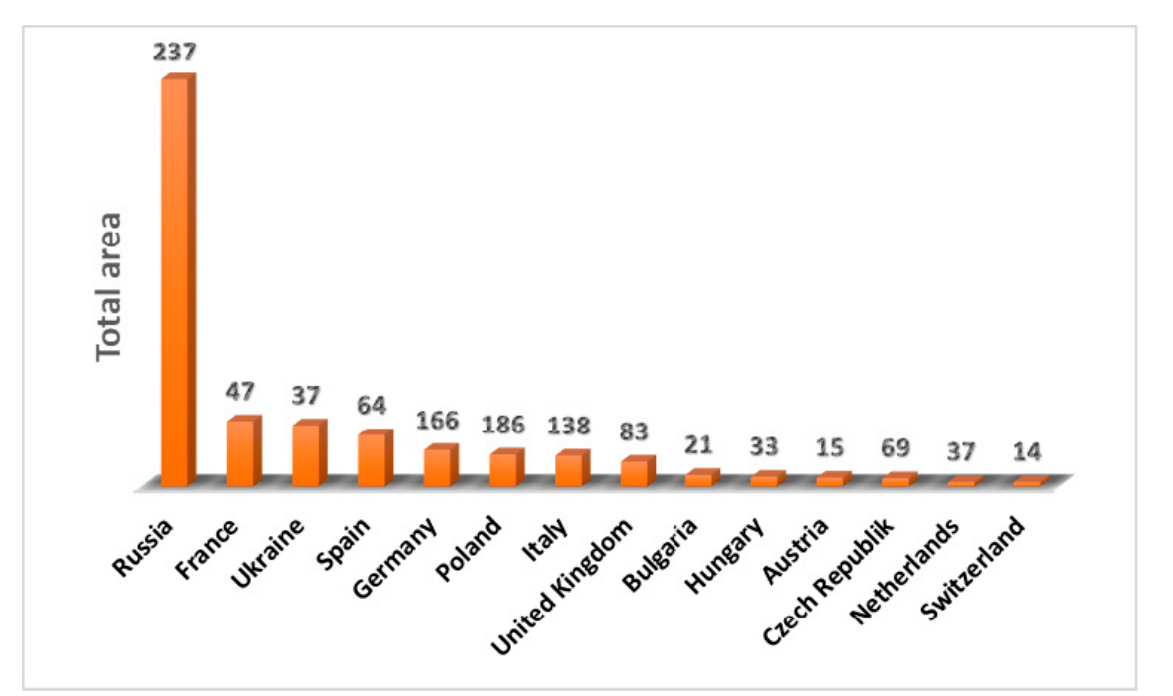
Figure 2. The size of European countries vs. the number of plastic recycling plants according to ENF [9].